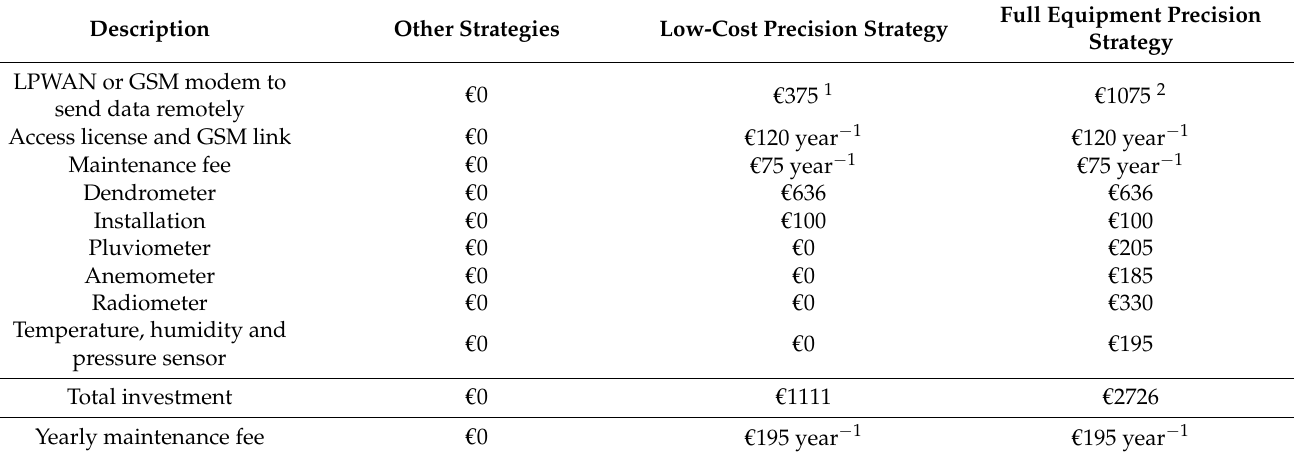
Table 11. Additional costs per irrigation sector for two different equipment levels to enable Precision irrigation